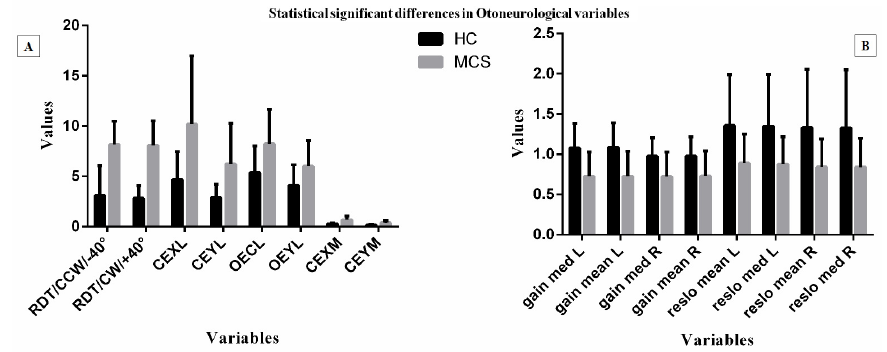
Figure 2. This represents all statistical significant differences in Visual Dependency scores, and spectral values of body oscillations ( A ) and video Head Impulse Test measurements ( B ) when comparing Multiple Chemical Sensitivity (MCS) and healthy subjects (HC). Acronyms represent tags for Rod and Disc test, RDT (counter ‐ clockwise, CCW; clockwise, CW), spectral values of body oscillations on X plane (X) and Y plane (Y) within low (L) and middle (M) frequency intervals recorded on stiff platform and during closed (CE) and opened eyes (OE) conditions and for vestibulo ‐ ocular reflex (VOR) gain and regression slope, reslo; L, left; R, right; med, median.